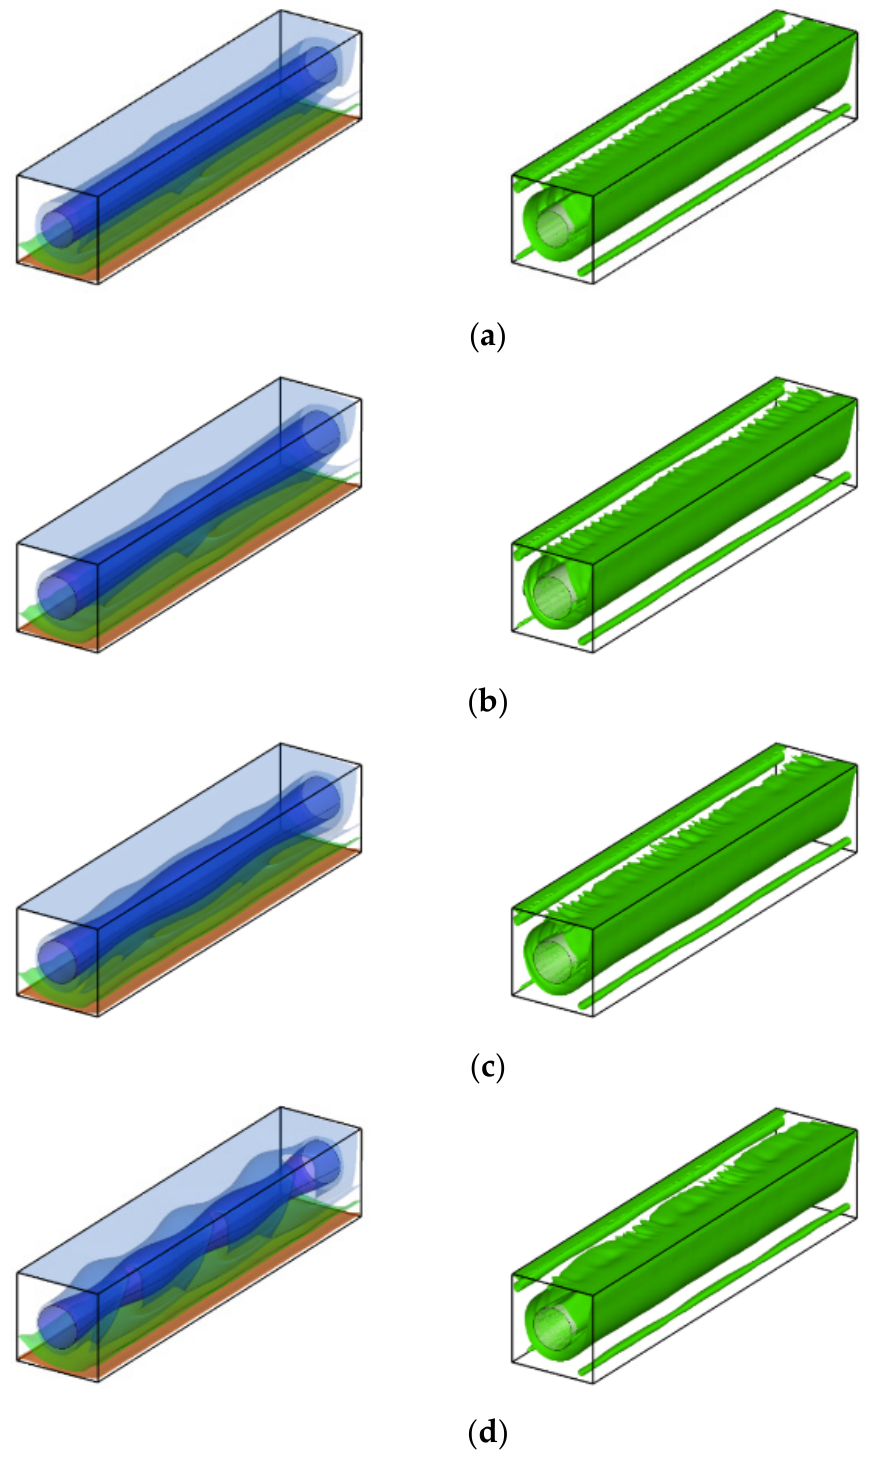
Figure 6. Distribution of temperature with θ = 0.1, 0.5, and 0.9 and vortical structure with λ 2 = − 0.1 as function of λ at Re = 1000. ( a ) λ = 0; ( b ) λ = 1; ( c ) λ = 2; ( d ) λ = 3.